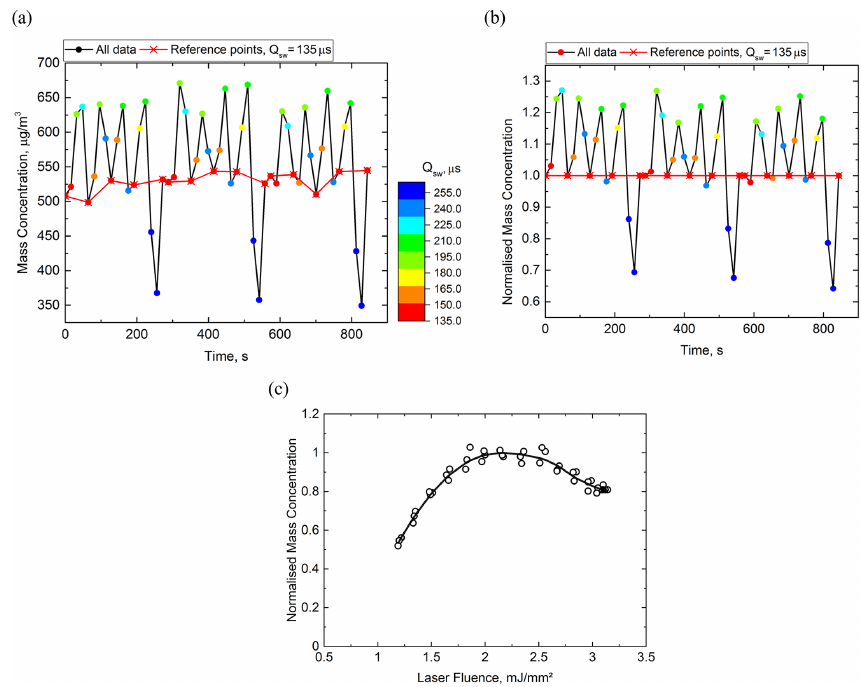
Figure 2. Laser fluence optimisation procedure for mass concentration showing (a) all raw measurements; (b) initially normalised measure- ments using the TN method; and (c) laser fluence sweep, superimposed with the best-fit curve (black) of the normalised mass concentration data using the Loess method with a second-order local polynomial regression.